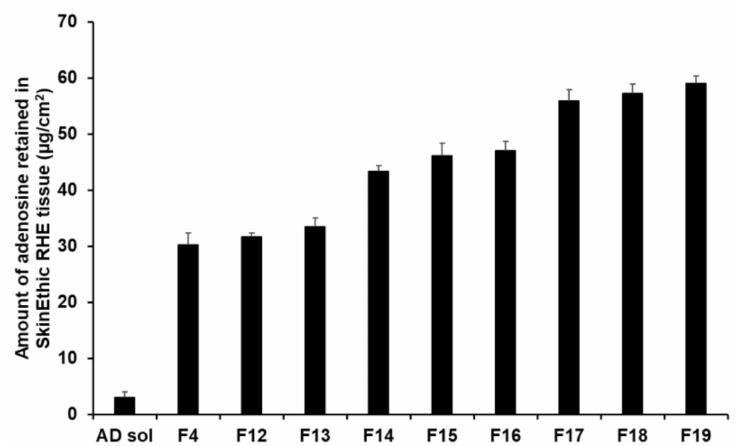
Figure 14. Results for AD retention from AD-loaded SLNs in SkinEthic RHE tissue after permeation studies. Results are expressed as means ± standard deviation of three independent experiments ( n = 3).